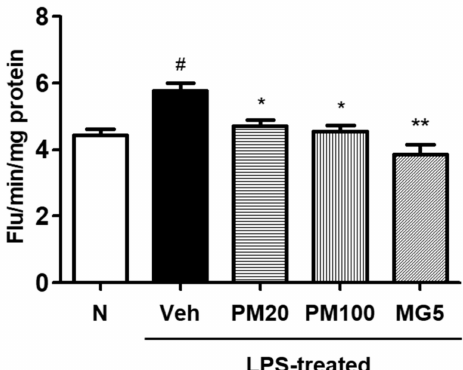
Figure 3. ROS content in the kidney. N, normal mice, Veh, vehicle-administered and LPS-treated mice; PM20, P. su ff ruticosa 20 mg / kg body weight-administered and LPS-treated mice; PM100, P. su ff ruticosa 100 mg / kg body weight-administered and LPS-treated mice; and MG5, methyl gallate 5 mg / kg body weight-administered and LPS-treated mice. One-factor ANOVA: # p < 0.05 versus normal mice; * p < 0.05 and ** p < 0.01 versus veh (vehicle-administered and LPS-treated mice). Bars indicate standard errors of means (S.E.M.).